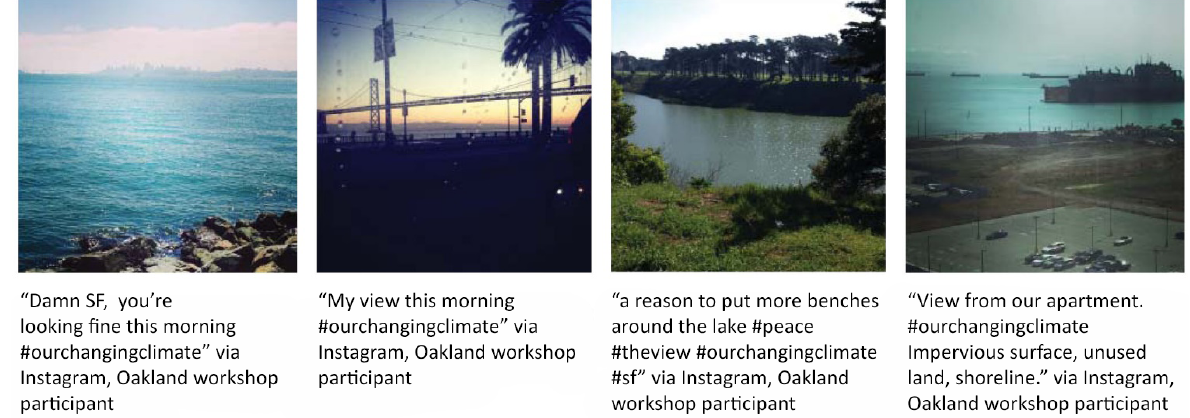
Figure 10. View-related